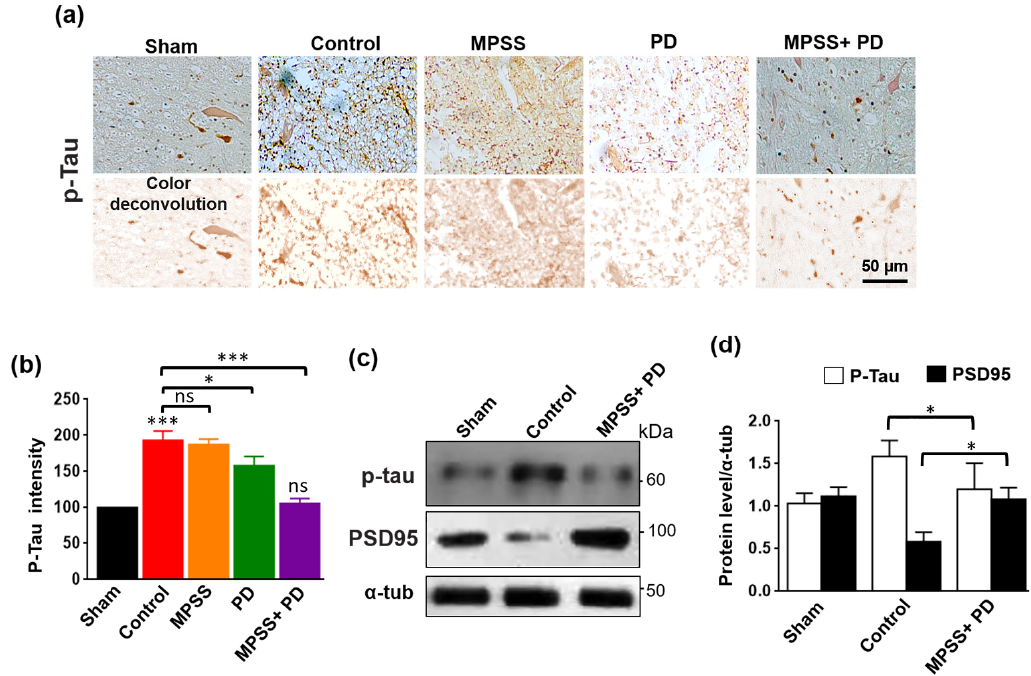
Figure 9. Inhibition of calpain attenuates tau hyperphosphorylation after SCI. ( a ) Representative images of phosphorylated-tau (AT8)-stained sections of the spinal cord from indicated groups after SCI. Specific staining of AT8 was upregulated in the control group, while MPSS+PD150606 admin- istration prevented this activation. ( b ) Quantitative analysis of the average p-tau intensity. Ten im- ages from each group were used for data quantification. Data are presented as the mean ± SD. * means p < 0.05, *** p < 0.001, and ns indicates non-significant. ( c ) Immunoblots showed the total protein levels of phosphorylated-tau and the scaffold postsynaptic protein PSD95 in the indicated groups. The treatment with MPSS+PD150606 abolished the increased levels of p-tau while preserv- ing the total protein levels of PSD95 after SCI. ( d ) Bar graph shows relative protein levels of p-tau and PSD95 in the indicated groups. Data are presented as the mean ± SD ( n = 3). * means p < 0.05.